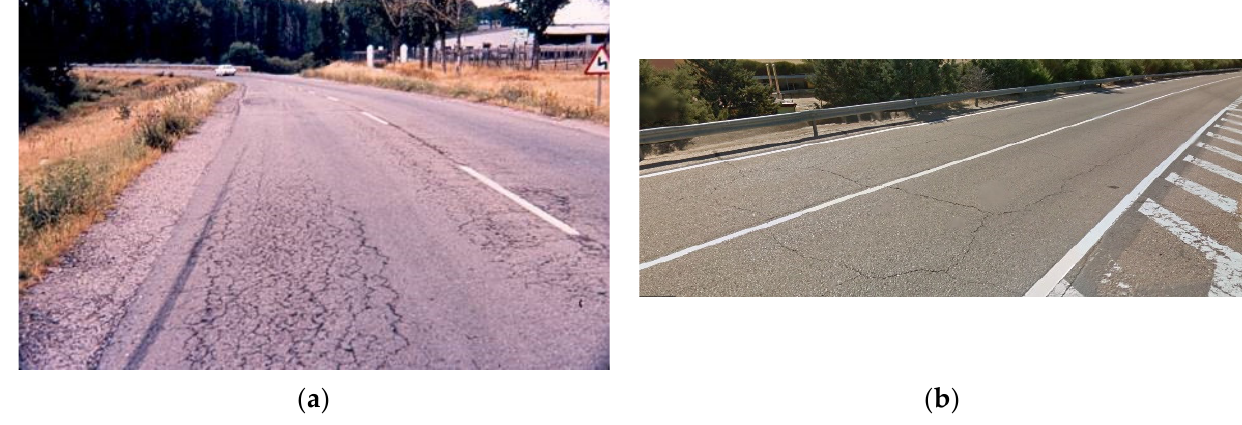
Figure 13. ( a ) Cracks from the top down and ( b ) Typical alligator skin cracking